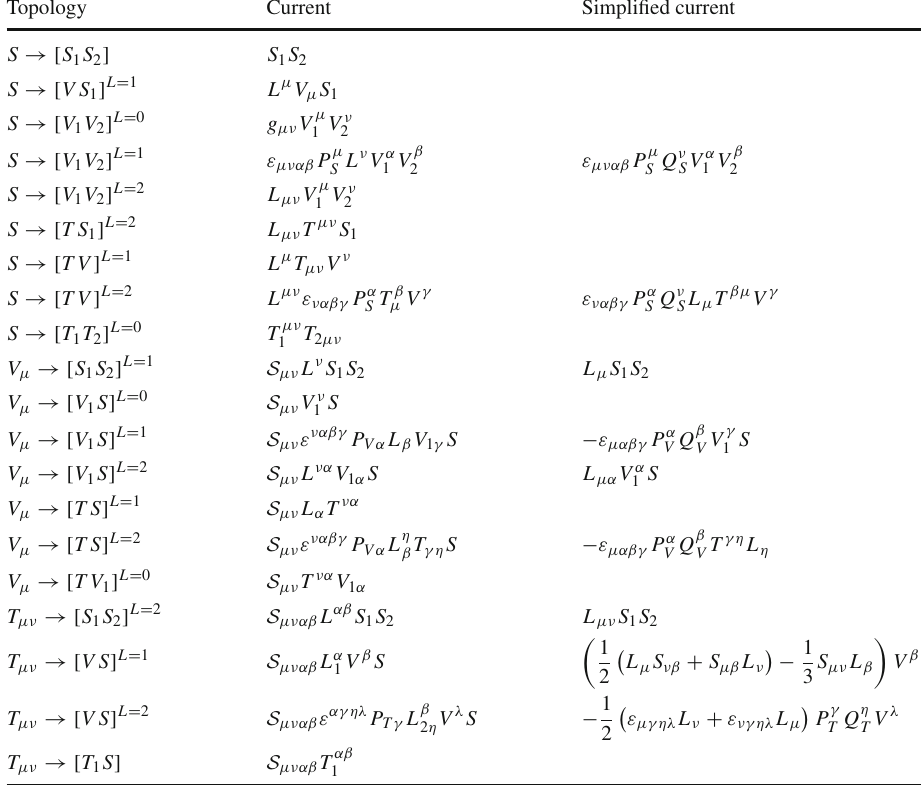
Topology Current